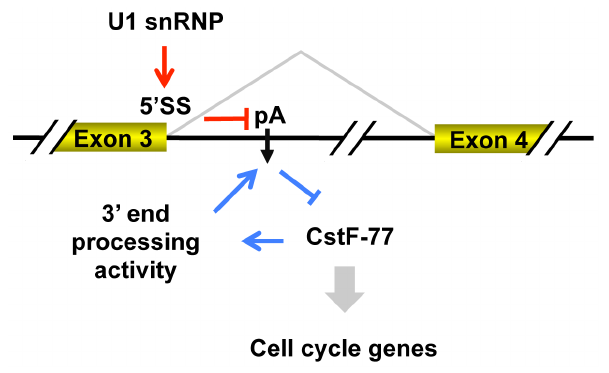
Figure 9. Model for regulation of intronic pA of the CstF-77 gene by 3 9 end processing and U1 snRNP, and its impact on expression of cell cycle genes.